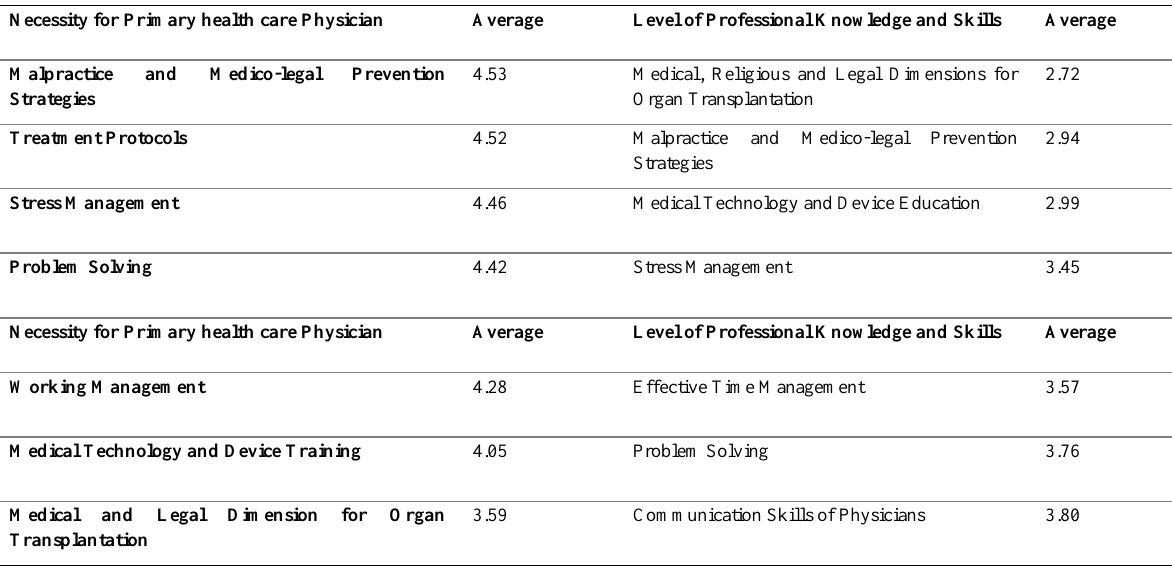
Table 26: Comparison of Necessity for Personal Development, Professional Knowledge and Skill Level of Primary Health